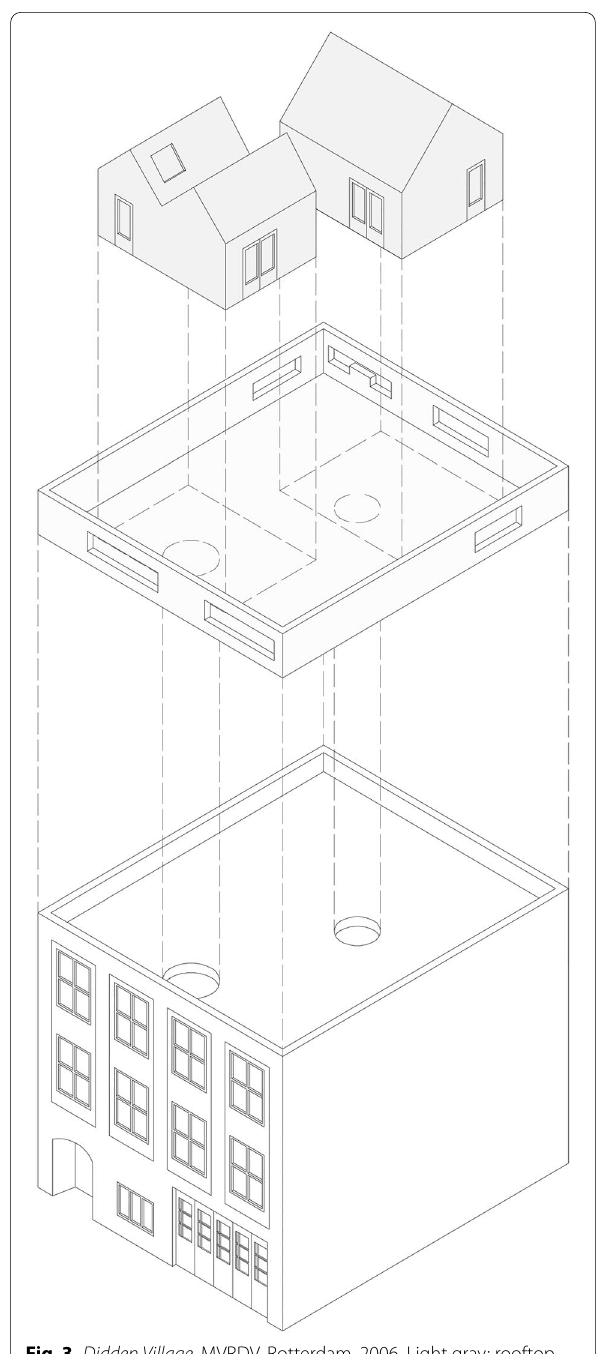
Fig. 3 Didden Village , MVRDV, Rotterdam, 2006. Light gray: rooftop